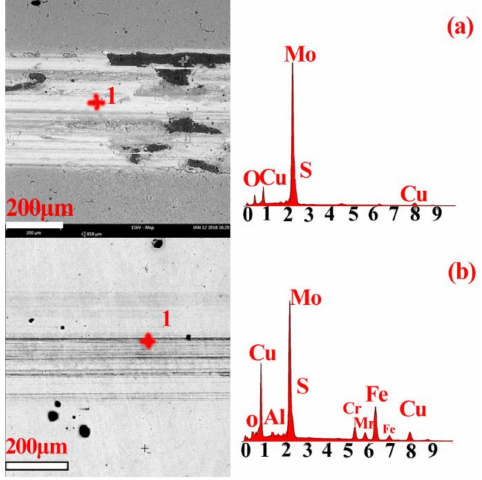
Figure 10. EDS analysis of worn surfaces. ( a ) Cu10; ( b ) Cu5Al5 annealed at 500 ◦